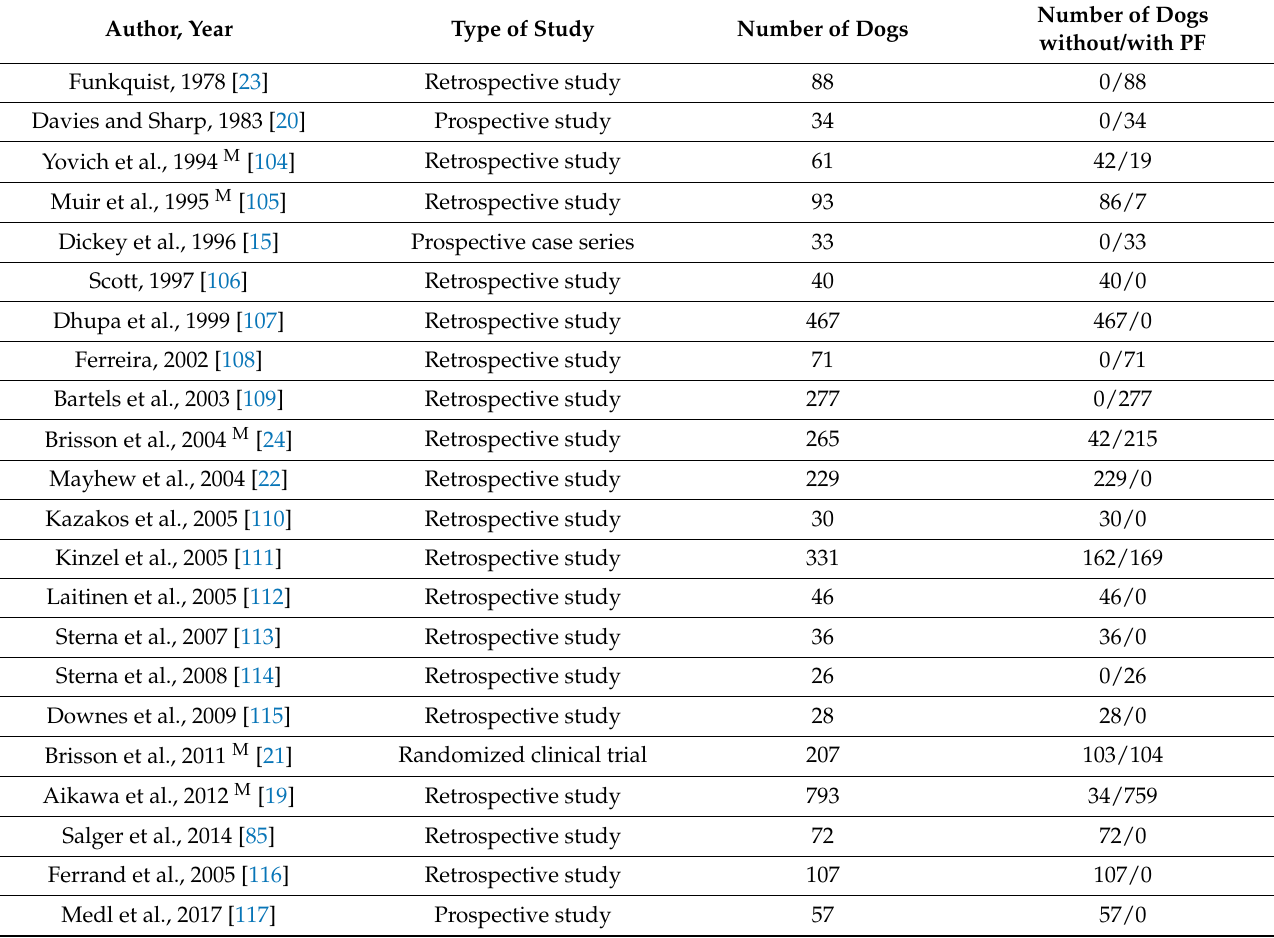
Table 2. Studies included in the systematic